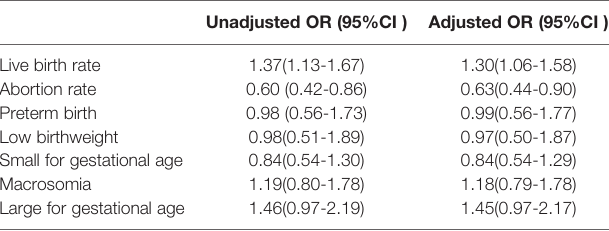
TABLE 4 | Unadjusted and adjusted odds ratios of reproductive outcomes of blastocysts transfer following L-FET versus HRT